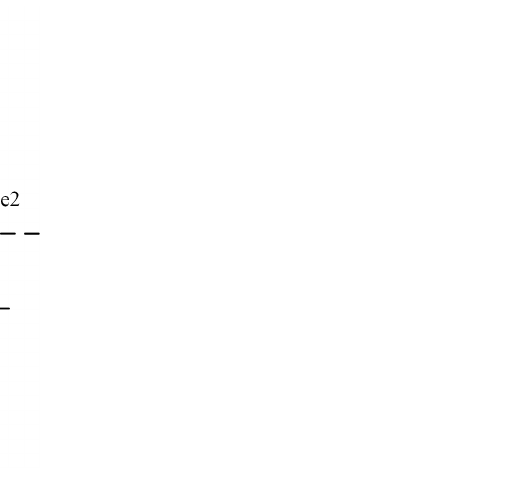
Figure 6. The corresponding relationship between the four directions of intersection and each gate.